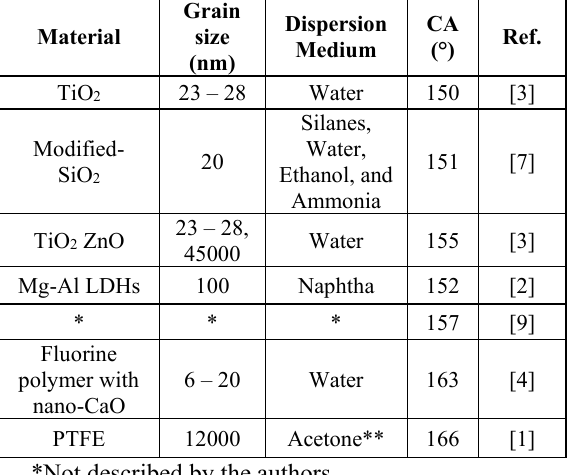
Table 1. Superhydrophobic Asphalt